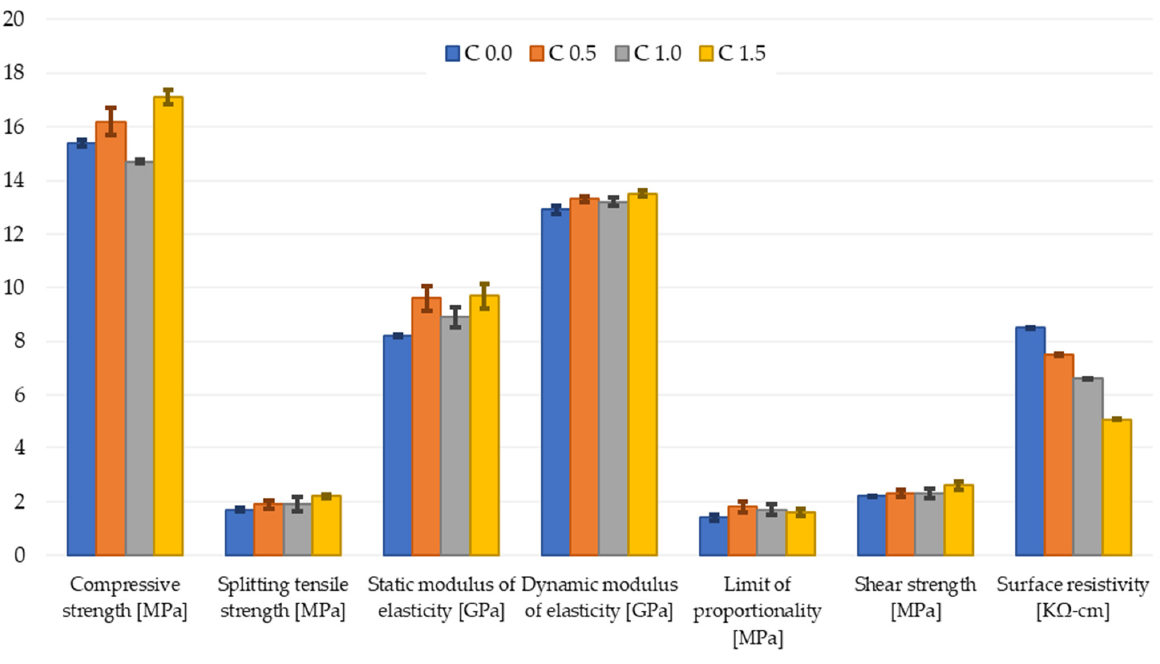
Figure 2. The overview of the experimentally measured data.